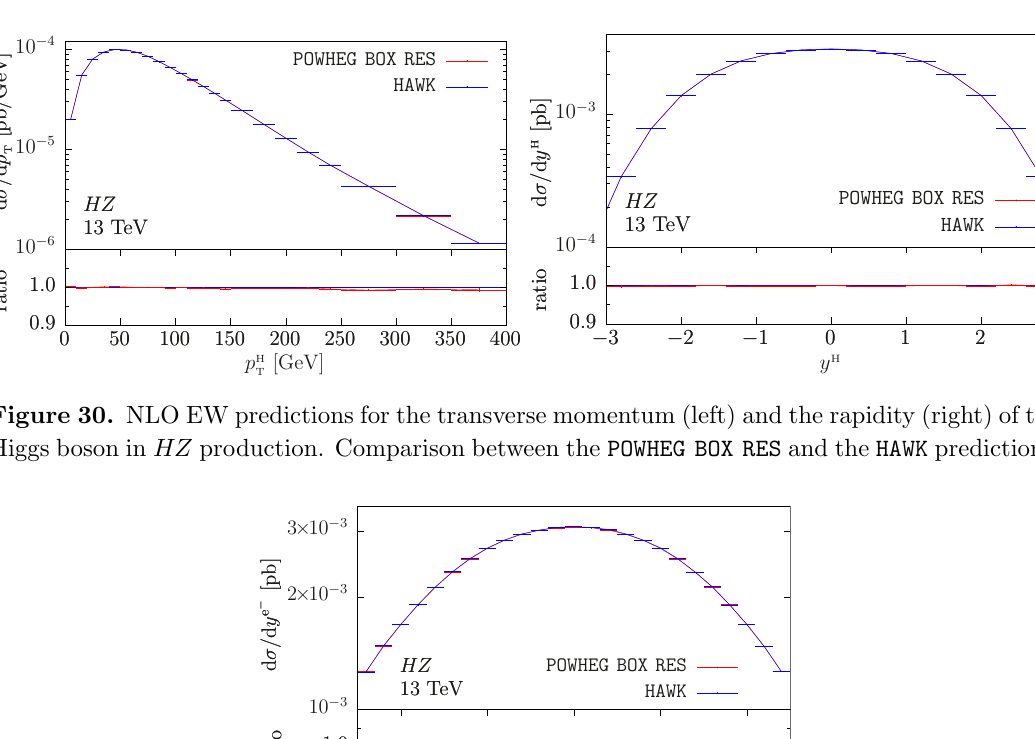
Figure 29. NLO EW predictions for the missing transverse momentum. Predictions and labels as in (cid:12)gure 28.